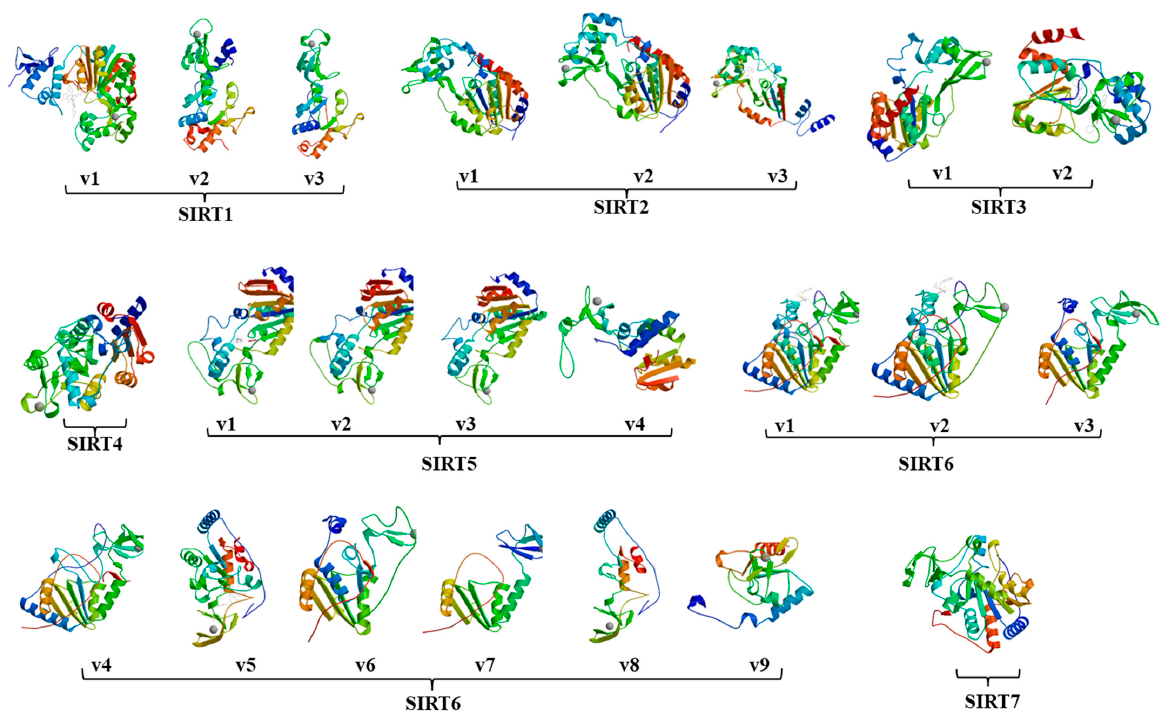
Figure 2. The 3-D sirtuin protein structure images that were generated using SWISS-MODEL software. Alternative splicing caused sirtuin protein domain loss and structural changes. Among the seven sirtuin genes, SIRT4 and SIRT5 genes had only one isoform each that was found in the RefSeq database.